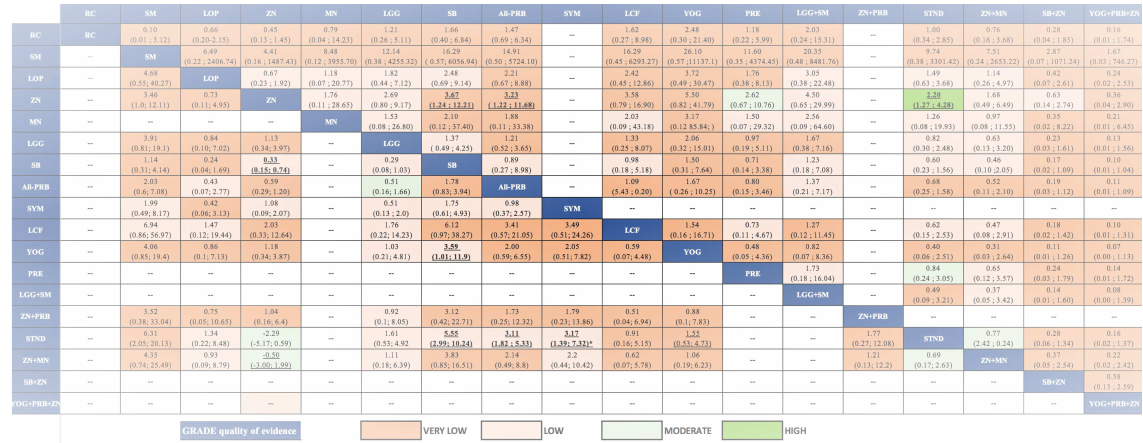
Fig 5. League table with NMA estimates for diarrhea at day 3 and vomiting. Comparisons should be read from left to right. The effectiveness estimate is located at the intersection of the column-defining treatment and the row-defining treatment. Diarrhea at day 3 (bottom part of the table) effect estimates are presented in odds ratio (OR) with the 95% CrI. A OR below 1.0 favours the column- defining treatment (less presence of diarrhea at day 3). Vomiting (upper part of the table) effect estimates are presented in Odds ratio (OR) with the 95% CrI, an OR below 1.0 favors the column-defining treatment (less presence of vomiting). To obtain ORs for comparisons in the opposing direction, reciprocals should be taken. Significant results are in bold and underlined font. Cells filling represent the GRADE quality of evidence assessment: Green: High quality; Light Green: Moderate quality; Light Orange: Low; Darker Orange: Very Low. Blank cells: not available interventions and comparisons. OR: Odds Ratio; 95CrI%: 95% Credible Intervals; NMA: Network Meta-analysis. Interventions’ abbreviations are described in Table